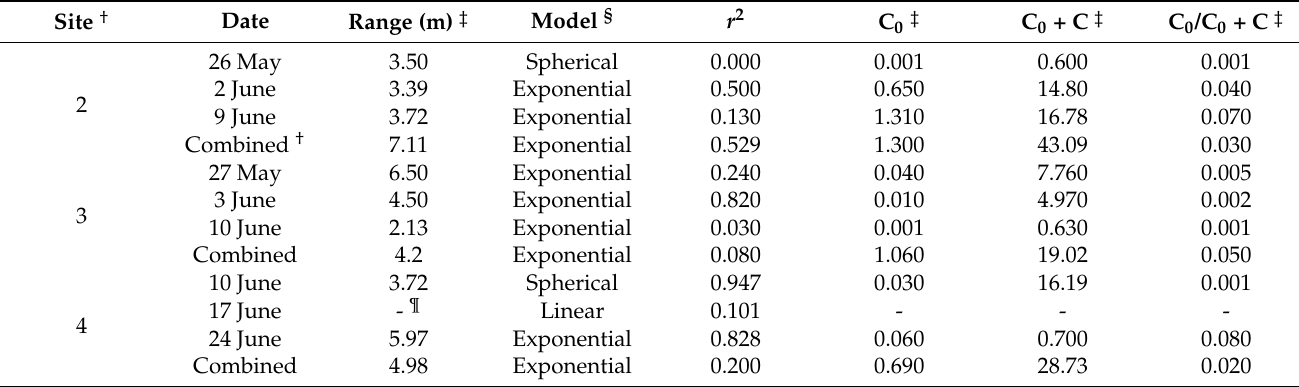
Figure 1. Interpolated map that was developed using the kriging based on variogram models of Sphenophorus spp. larvae from sod field sites ( A ) 1, ( B ) 2, ( C ) 3, and ( D ) 4 in Marshallville, Georgia (USA) in 2019 and 2020. Three-week samples were combined to form a cumulative sample at each site. Sites 1 and 2 were sampled in fall and winter 2019, and sites 3 and 4 were sampled in spring 2020. Table 2. Variogram models and parameters representing the spatial distribution patterns of Sphenophorus venatus vestitus adults at three sites in Marshallville, Georgia (USA), in 2020.